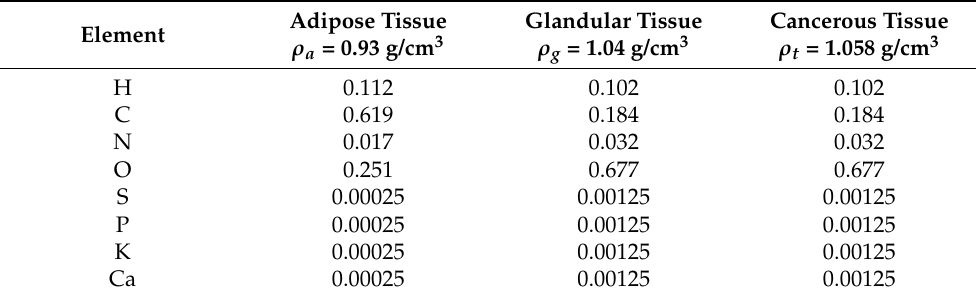
Table 3. Elemental composition of simulated tissues. The values in the table show the mass fraction of the elements.